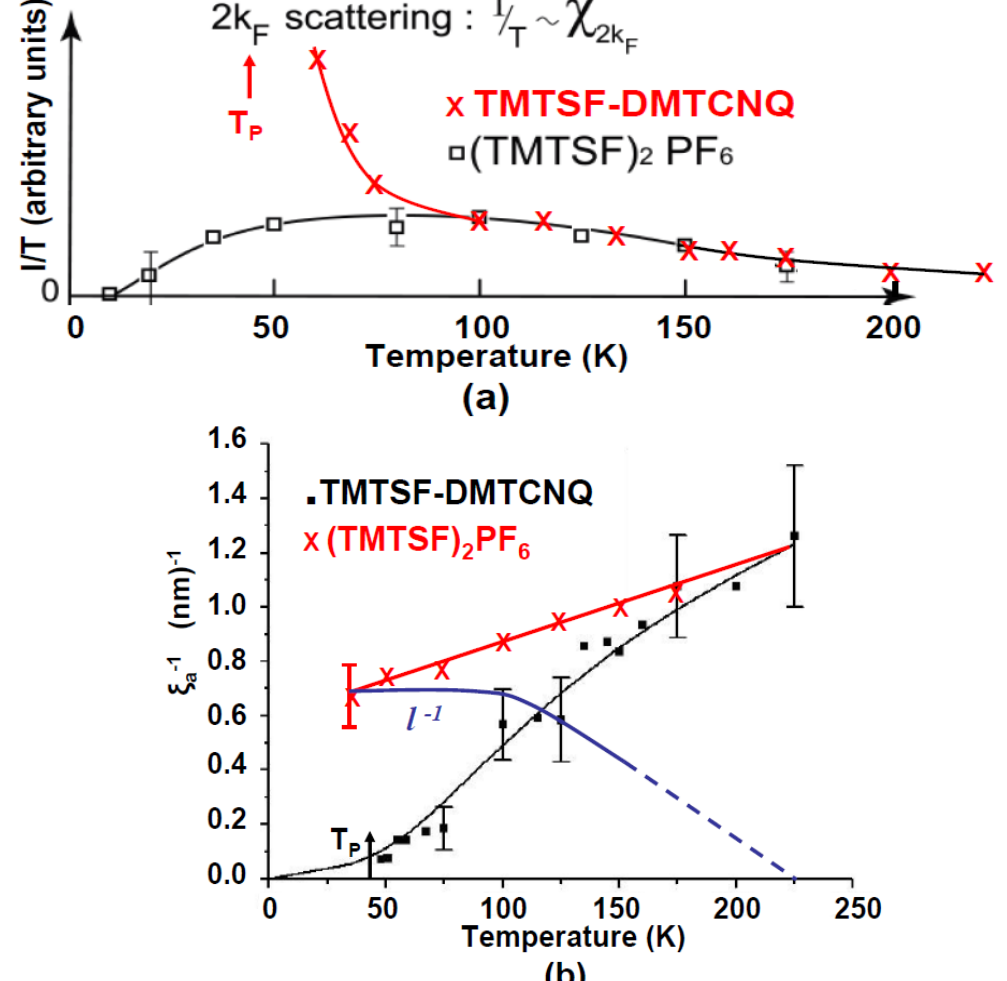
Figure 2. Thermal dependence of ( a ) the 2k inverse intra-chain correlation length ξ a−1 in (TMTSF) (b) the thermal dependence of the inverse mean free path l −1 of the electron-hole pairs of (TMTSF) PF , given by (4), is given by the blue 2 6